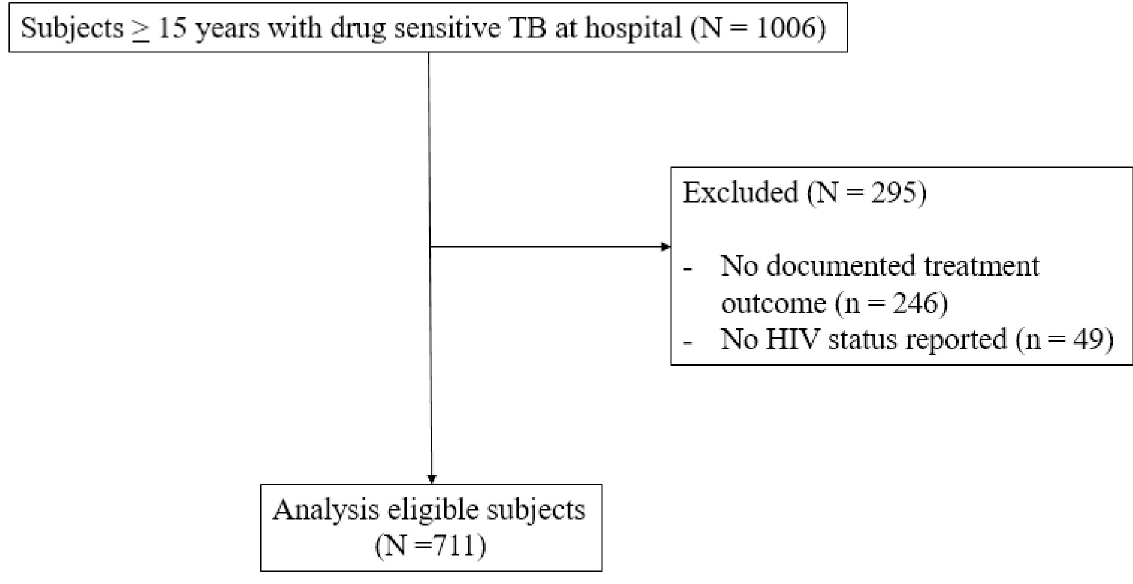
Fig 1. Population